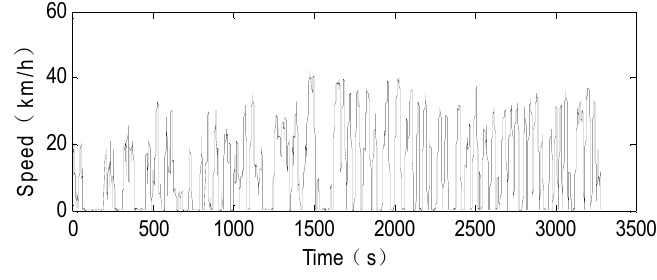
Figure 11. Vehicle speed curve.